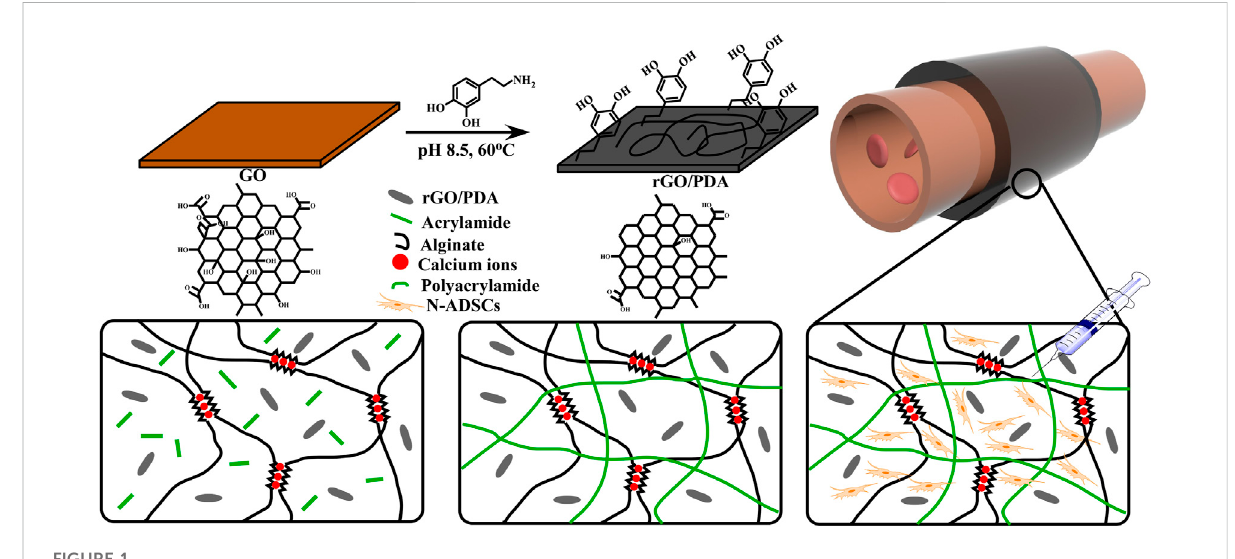
FIGURE 1 Schematics and fabrication process of the N-ADSC-loaded adhesive DN hydrogel. (A) Dopamine molecules were attached to graphene oxide (GO) sheets. (B) PDA chains were formed and GO was reduced. (C) The adhesive hydrogel was wrapped around an artery for repair. (D,E) Structure andpolymerizationprocess ofthedoublenetwork (DN) hydrogel. (F) N-ADSCs wereinjected intothehydrogel matrix. N-ADSCs,Netrin-1-modi fi ed adipose-derived stem